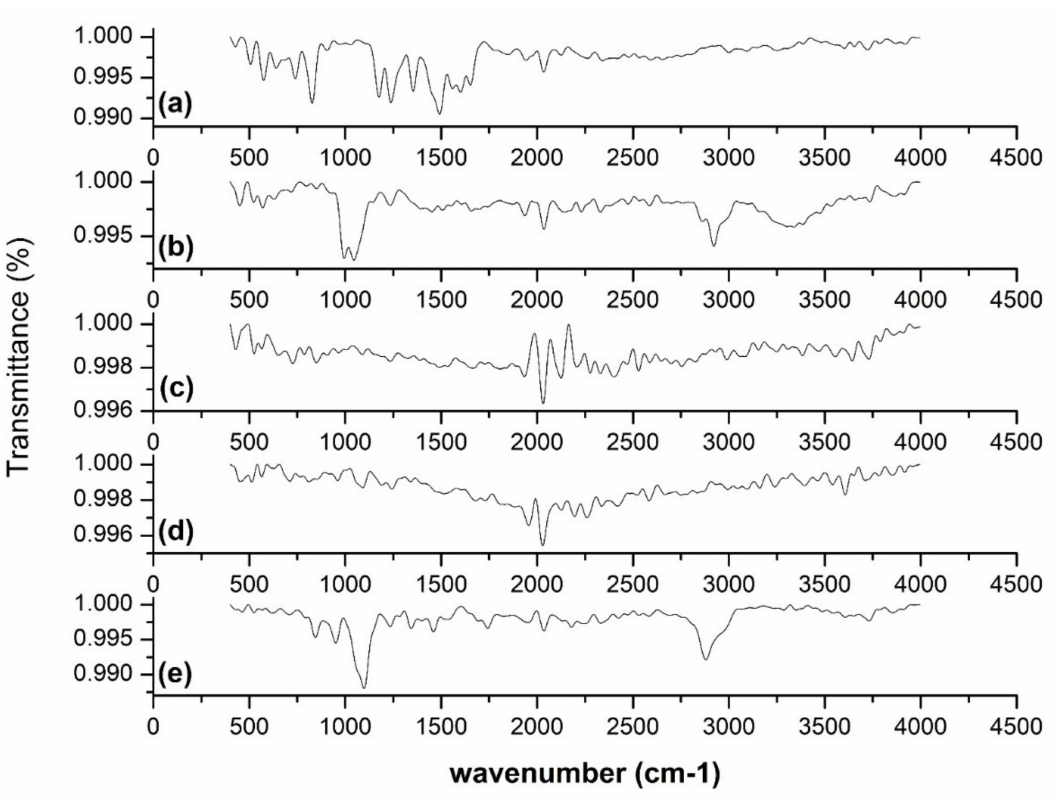
Figure 4. FT-IR spectra of ( a ) AGN, ( b ) LPHyNP, ( c ) PLGA, ( d ) SPC-3, and ( e ) TPGS.